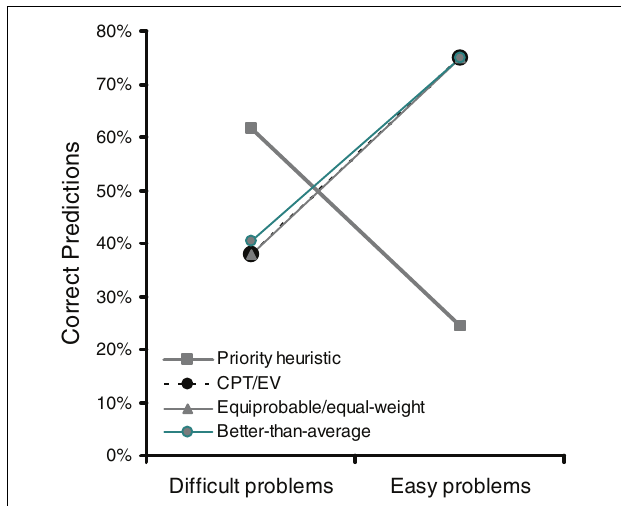
FIGURE 5 | In easy problems, heuristics that make trade-offs can account for choices equally well as cumulative prospect theory (CPT) and expected value (EV) theory. Data are from Experiment